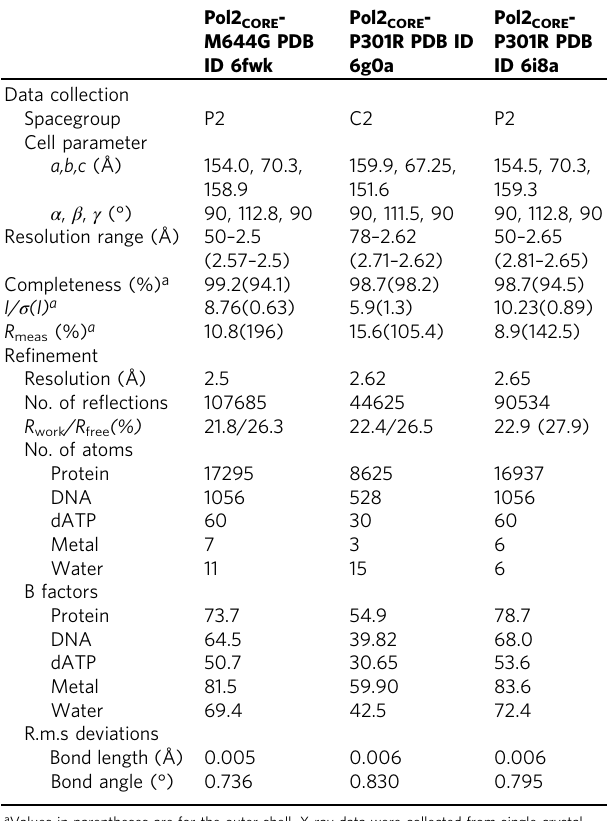
Table 1 Data Collection and re fi nement statistics (molecular